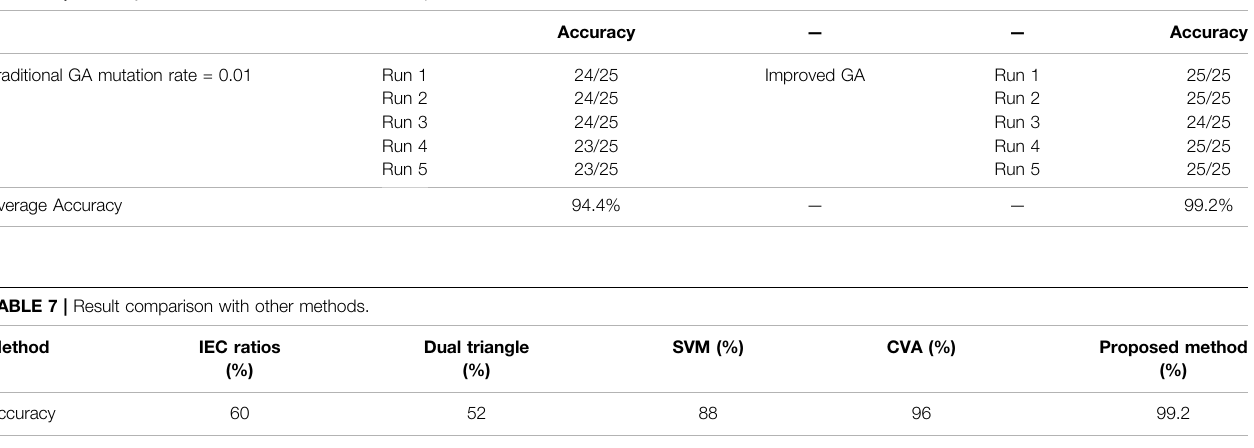
TABLE 6 | Accuracy of different methods for the test samples.